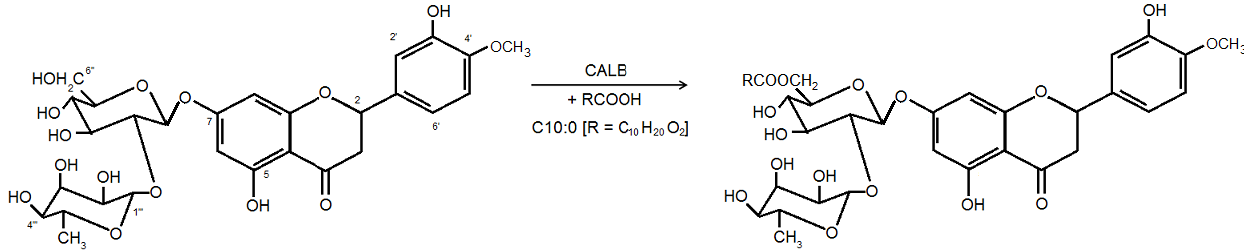
Figure 1. Reaction progress of the enzymatic acylation of hesperidin (100 mM) with decanoic acid (500 mM) catalyzed by immobilized CALB (8.0 mg/mL) in [bmim]BF acetone (5:5, v/v) at 50 °